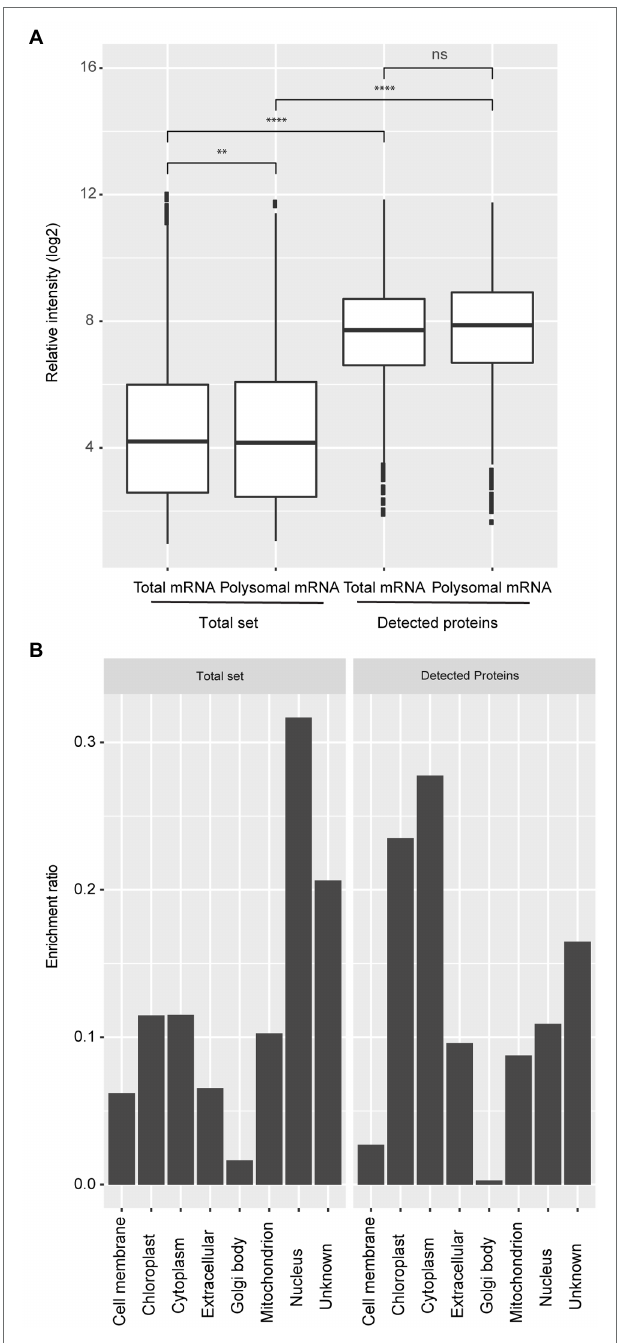
FIGURE 1 | Expression bias of detected protein coding genes and their predicted subcellular localization. (A) Boxplots representing the expression level of total and polysomal mRNA identified in the total set of genes that are expressed in seeds (Total set) and total and polysomal mRNA of the subset for which proteins have been identified (Detected proteins). The boxplots are based on the data from five time-points with three biological replicates (ns; p > 0.05; ** p < 0.01; *** p < 0.001; **** p < 0.0001; Wilcoxon rank-sum test). (B) Classification of subcellular locations of the genes for the whole set (Total set) and subset (Detected proteins). The ratio was calculated by dividing the number of genes/proteins from each subcellular location and the total number of genes/proteins identified from each